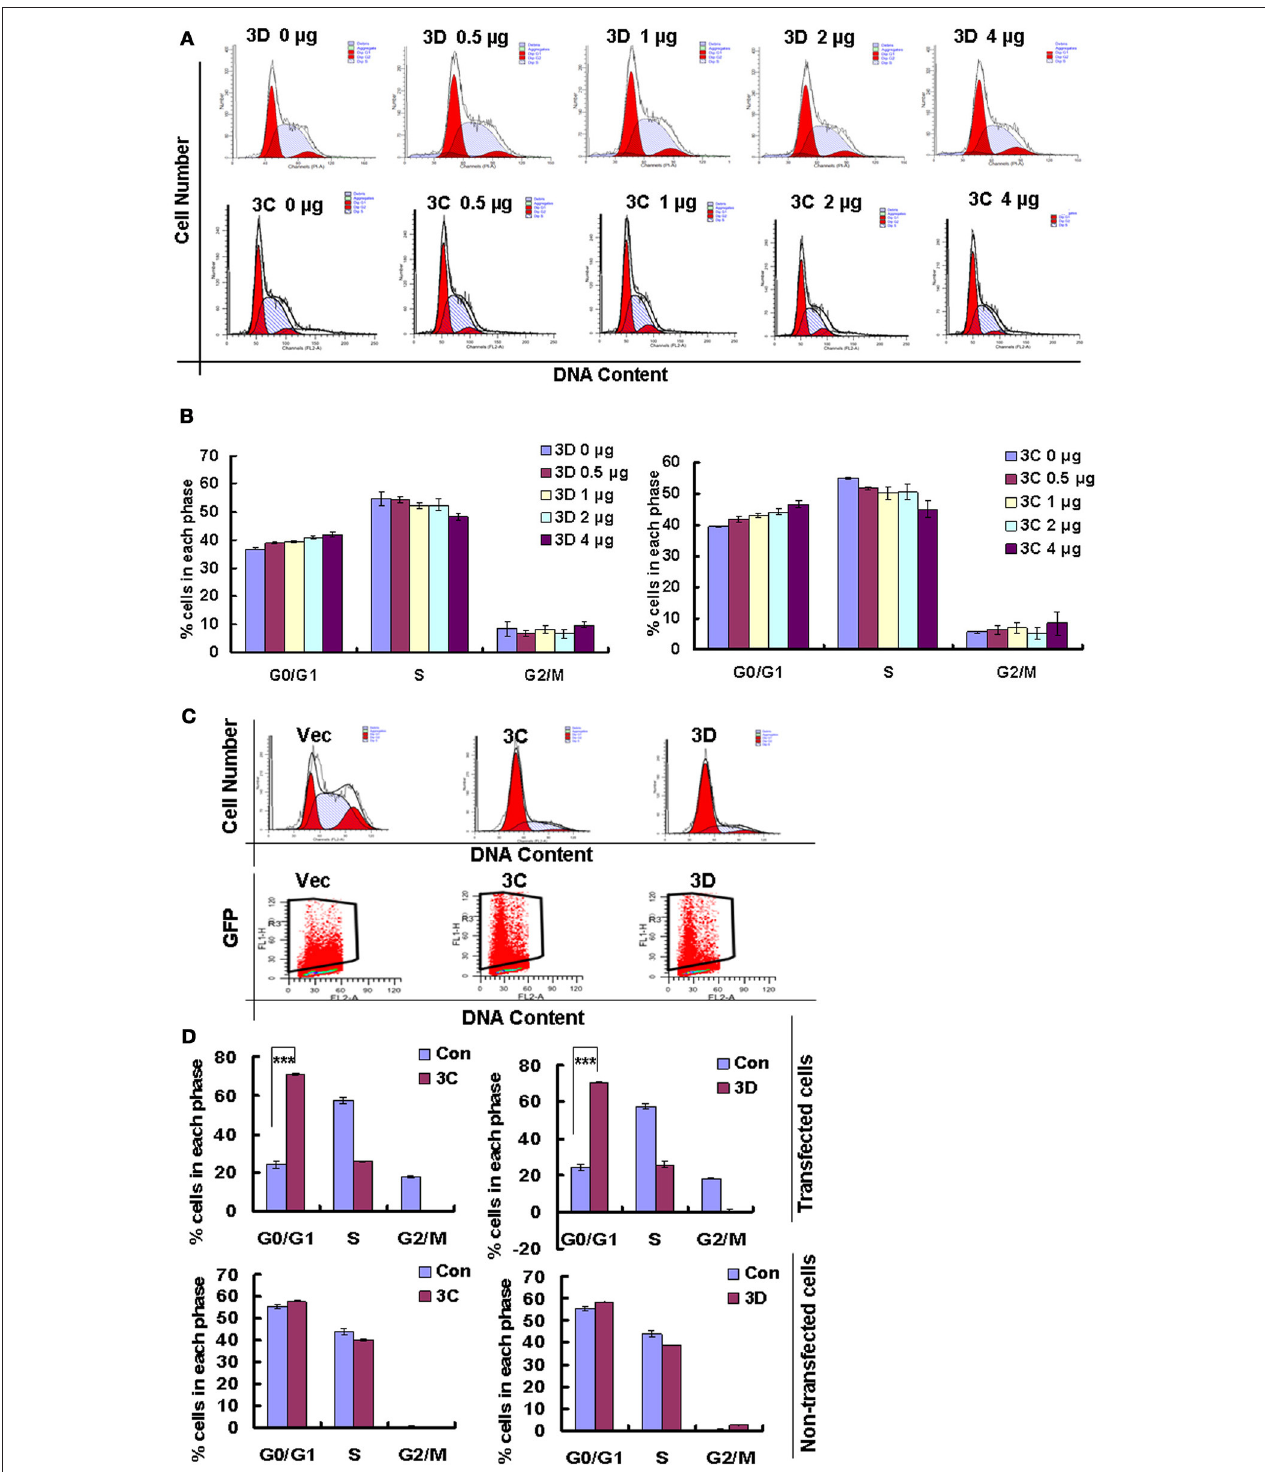
FIGURE 8 | The effect of non-structural proteins 3D and 3C on G0/G1-phase arrest. (A) The cell cycle distribution in 293T cells was analyzed at 36h after transfection with 0, 0.5, 1, 2, or 4 µ g plasmid as indicated. (B) The histograms indicating the cell cycle distribution were analyzed by the ModFit LT program. The results indicate the mean ± SD of three independent experiments. (C) The cell cycle distribution and fluorescence density in 293T cells were analyzed at 36h after transfection with 4 µ g PEGFP (Vec), 3C-PEGFP (3C) and 3D-PEGFP (3D) plasmid. (D) The histograms displaying the cell cycle distribution were analyzed by the ModFit LT program. Top panel: Cells with green fluorescence indicated successful transfection. Bottom panel: Cells without green fluorescence indicated non-successful transfection. The results indicate the mean ± SD of three independent experiments. *** P < 0.001.